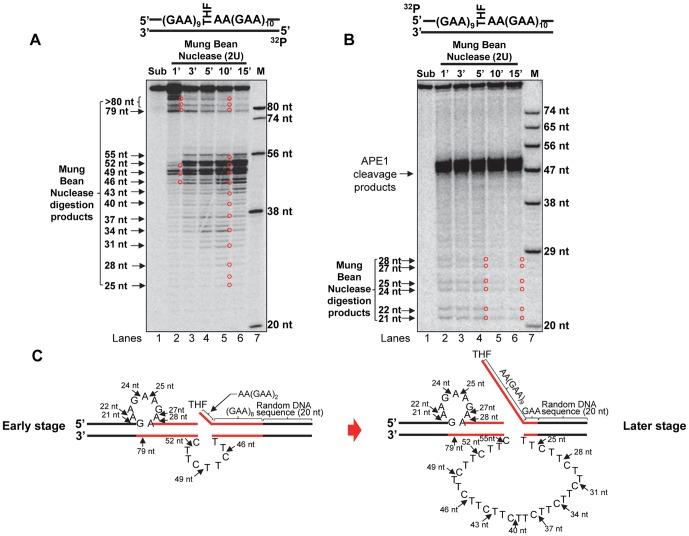
Formation of single-stranded loop structures on the damaged and template strands during BER of an abasic lesion in a (GAA)20 repeat tract.The secondary structures formed on the damaged and template strands of the (GAA)20 repeat-containing substrate with an abasic lesion located in the middle of the repeat tract, were probed by Mung Bean Nuclease digestion under the conditions described in the Materials and Methods. (A) Formation of secondary structures on the template strand was probed by incubating 2 U Mung Bean Nuclease with the substrate radiolabeled at the 5'-end of the template strand at various time intervals. Lane 1 represents the undigested substrate. Lanes 2−6 represent the digestion products generated at various time intervals. Lane 7 represents synthesized size markers (M). (B) Formation of secondary structures on the damaged strand was probed by incubating Mung Bean Nuclease with the substrate radiolabeled at the 5'-end of the damaged strand at various time intervals. Lane 1 represents the substrate only. Lanes 2−6 represent the Mung Bean Nuclease cleavage products generated at various time intervals. Lane 7 represents synthesized size markers (M). (C) Deduced loop structures formed on the damaged and template strands of the (GAA)20 repeat substrate during BER are illustrated schematically below the gels. Mung Bean Nuclease digestion sites are indicated.